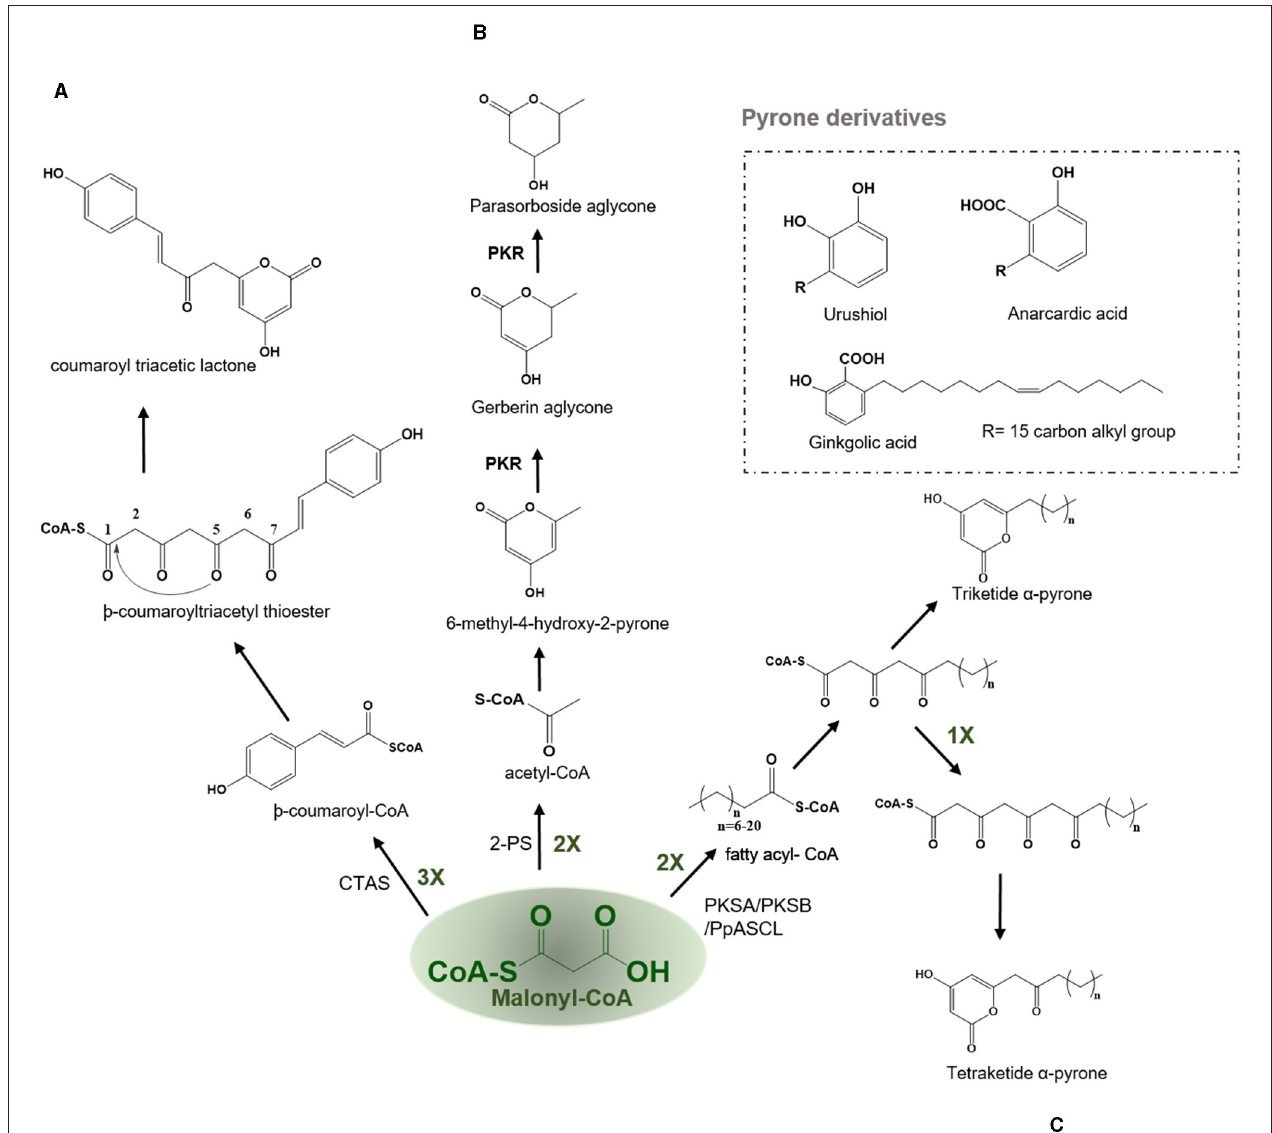
FIGURE 6 | Examples of lactonization type reaction employed by various type III PKSs to produce a variety of polyketide products. Describes the reaction catalyzed by (A) Coumaroyl triacetic acid synthase (CTAS), (B) Pyrone synthase (2-PS), and (C) PKSA (lap6) and PKSB (lap5); PKS, polyketide reductase; PpASCL, anther specific chalcone like